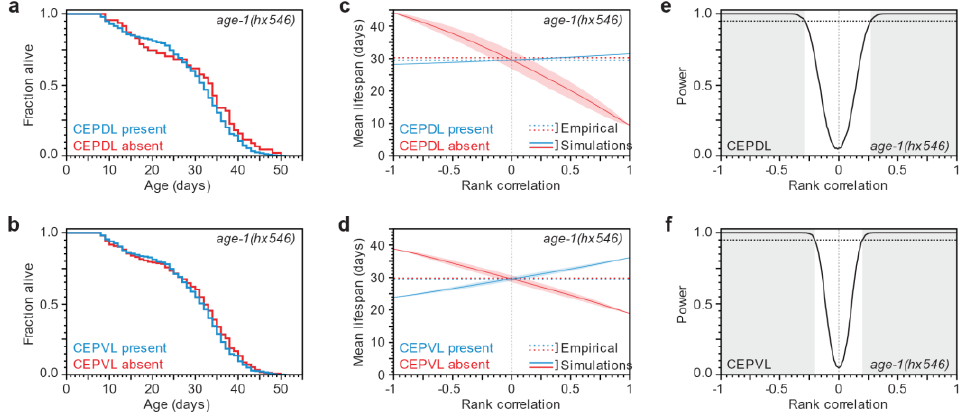
Figure 5. Independence of neuronal loss and organismic death in age-1 mutant animals. ( a , b ) No difference in lifespan was observed when 542 seven-day old age-1 ( hx546 ) mutants expressing α-synuclein in the dopaminergic neurons were grouped according to whether the specified cephalic neuron was present (blue line) or absent (red line). For statistics see Table S2; ( c , d ) Using computer simulations (Figure 3), we predicted how the mean lifespans of seven-day old animals with present (blue line) and absent (red line) cephalic neurons are influenced by the Spearman’s rank correlation between the timing of neuronal loss and lifespan. The shaded areas represent the 95% point-wise confidence interval of the predicted mean lifespans. The observed mean lifespans (dotted lines) are only consistent with correlations of low magnitude; ( e , f ) The statistical power of our experiment is the fraction of simulations with a significant ( p < 0.05) difference in survival between the neuron present and absent groups. The shaded region denotes the Spearman’s rank correlation values where statistical power is greater than 95% (dotted line). For the analysis of based on the state of CEPDR and CEPVR on day 7 see Figure S4, Supplementary Materials.